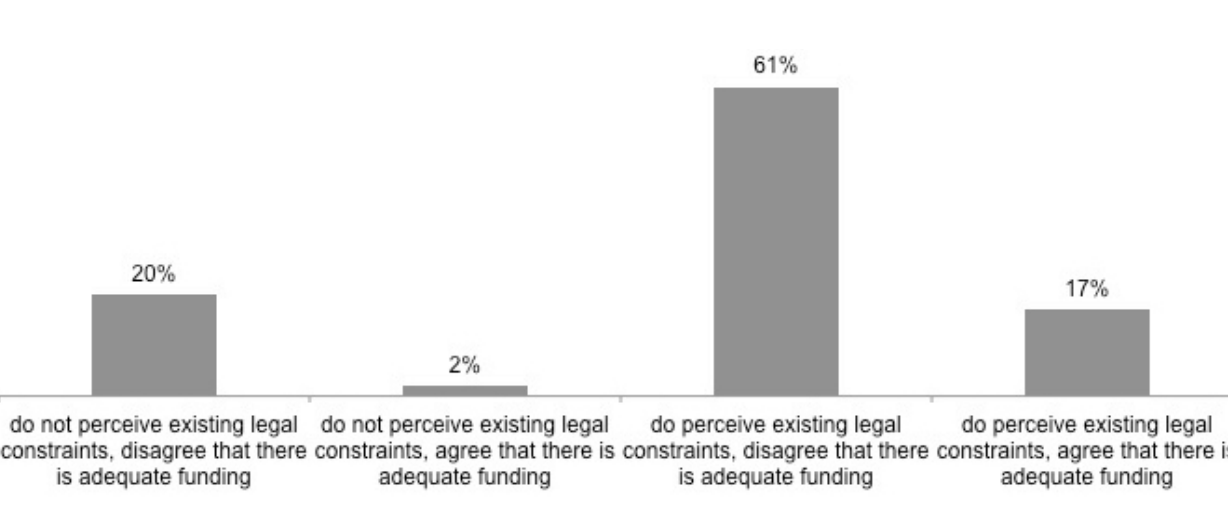
Fig. 6. Respondents’ perceptions of existing legal constraints and funding were negatively correlated: Those who reported that laws and other administrative and regulatory requirements constrain efforts to engage in adaptive management also reported that monitoring is not adequately funded for adaptive management efforts ( R = -0.460, P < 0.05). Data was aggregated to “agree” and “disagree” for